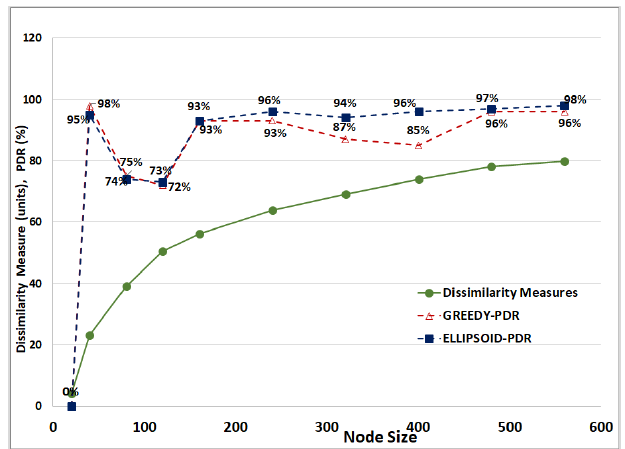
Figure 7. Dissimilarity distribution of the packet forwarding distance averages; and the PDR. (MANET